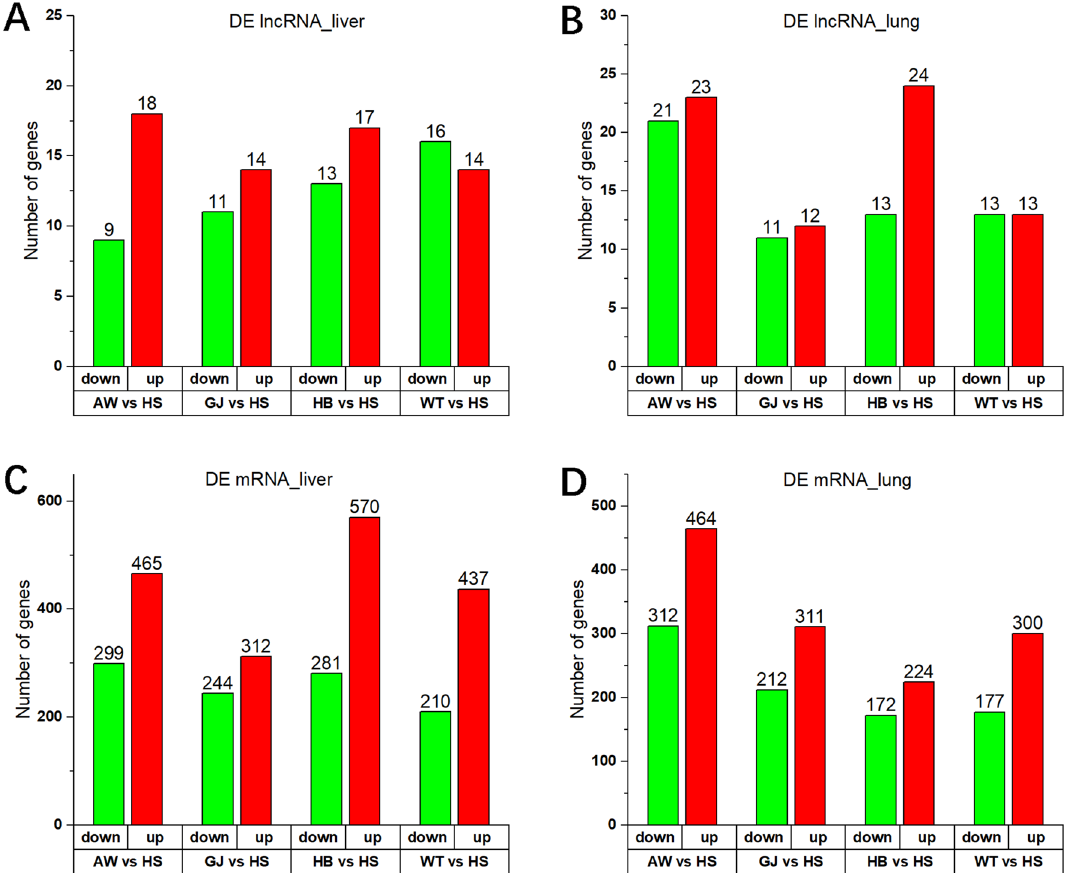
Figure 3. The up and down regulation of DE genes of five sheep populations. ( A ) Number of DE lncRNAs in liver samples. ( B ) Number of DE lncRNAs in lung samples. ( C ) Number of DE mRNAs in liver samples. ( D ) Number of DE mRNAs in lung samples. Red: up-regulated; Green: